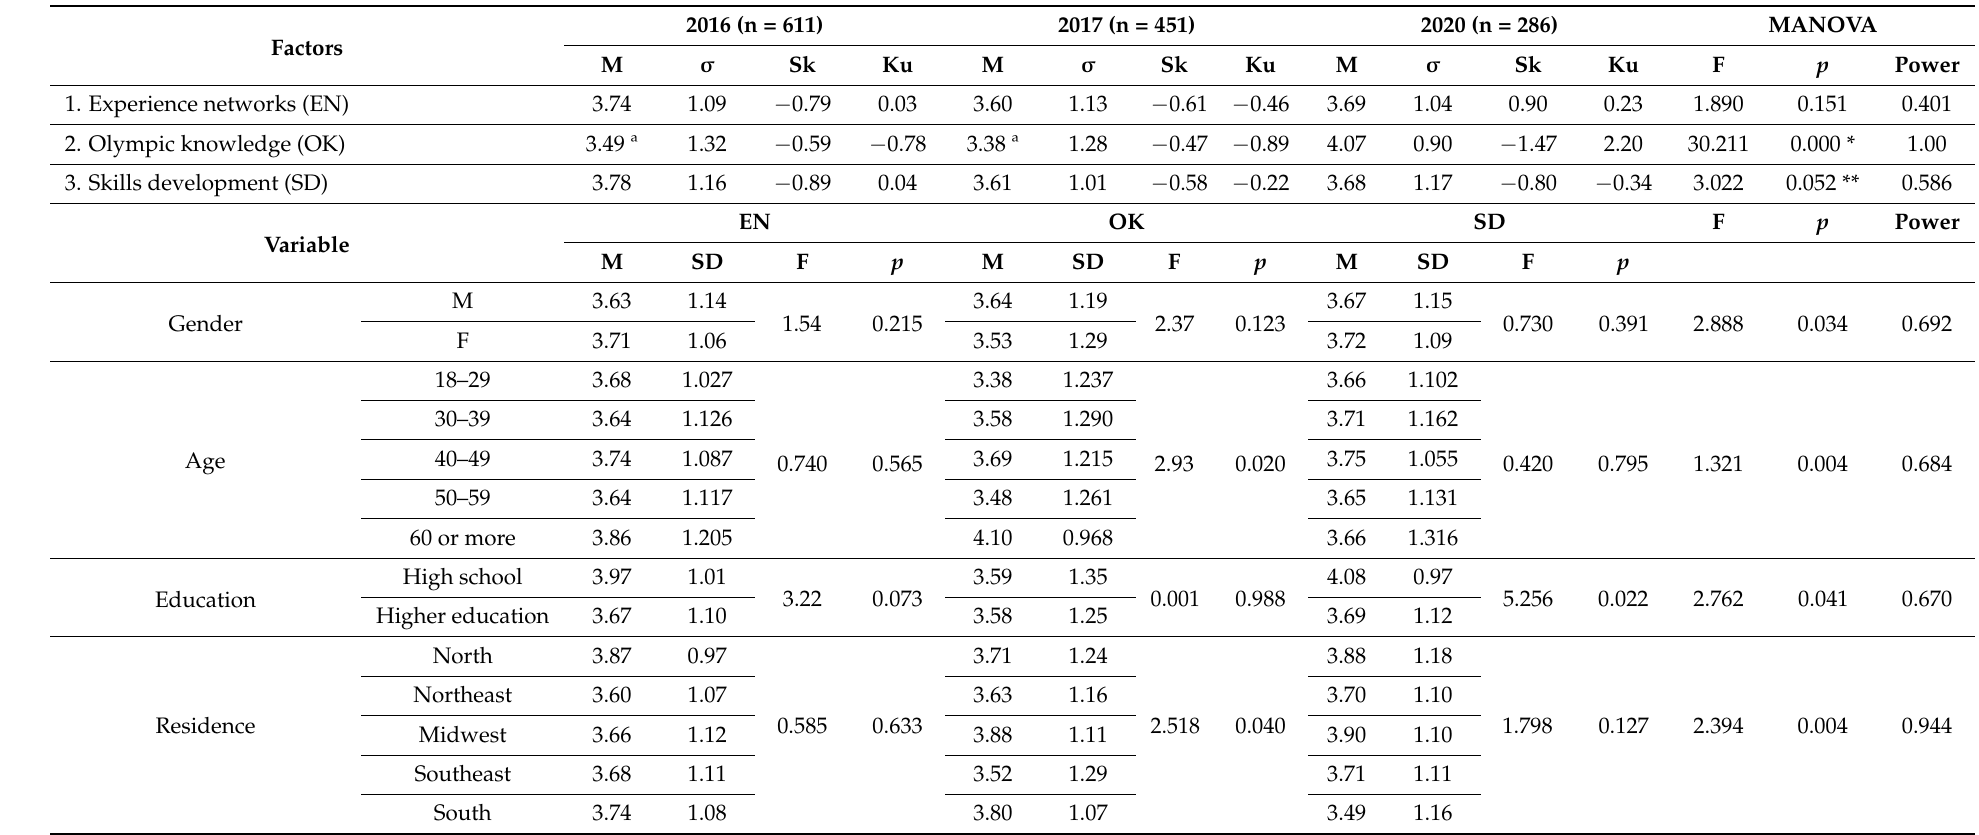
Table 2. Descriptive statistics and MANOVA